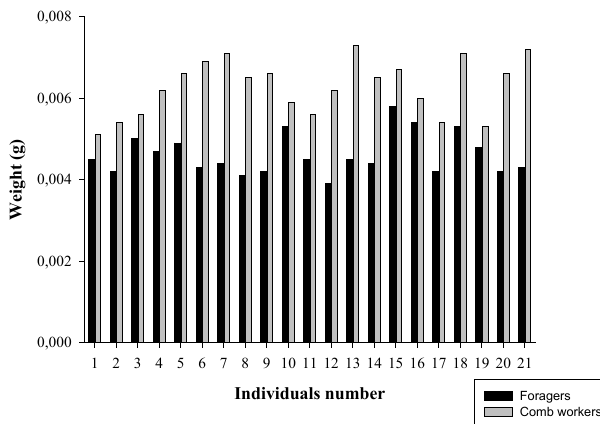
Fig 3. Weight of individuals separately (21 foragers and 21 comb workers). The foragers were lighter because they have less adipose tissue for the flight (Michener,